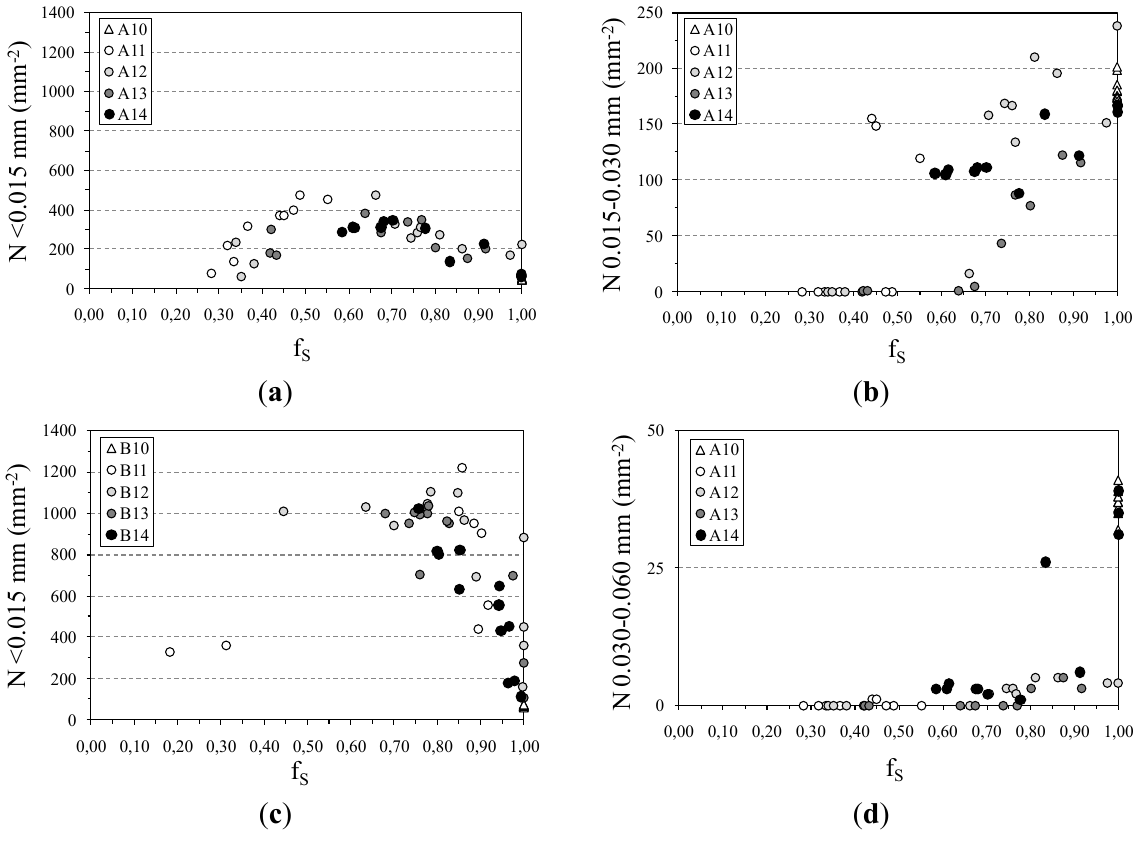
Figure 10. Nodule count evolution during solidification process (all fields are included). ( a ) Smallest nodule count evolution vs. fs for A1 series; ( b ) 0.030–0.060 mm nodule count evolution vs. fs for A1 series; ( c ) Smallest nodule count evolution vs. fs for B1 series; ( d ) 0.030–0.060 mm nodule count evolution vs. fs for A1